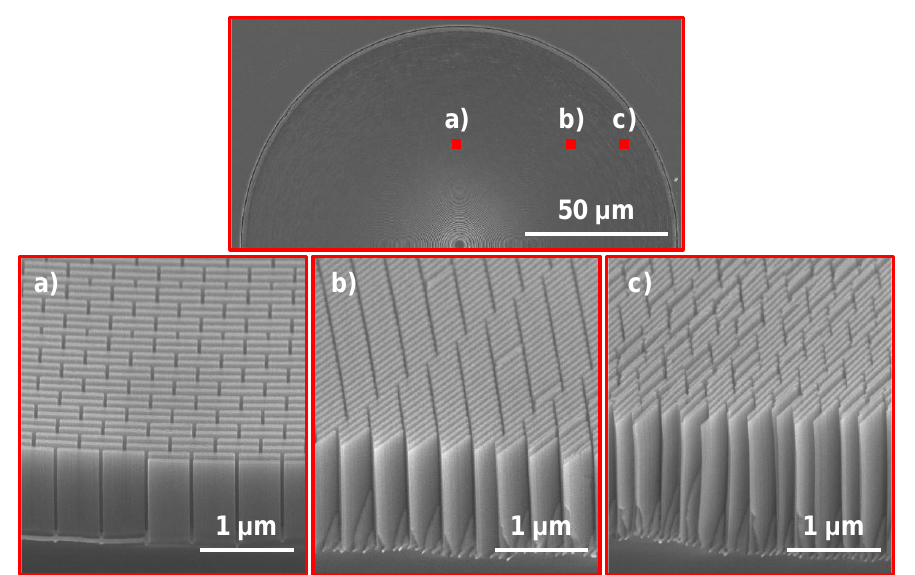
Figure 3. Brick wall catalyst design processed at MACE condition C1. The top micrograph shows where the three micrographs labeled ( a – c ) are localized on the zone plate. The cross-sections were prepared by manual cleaving.